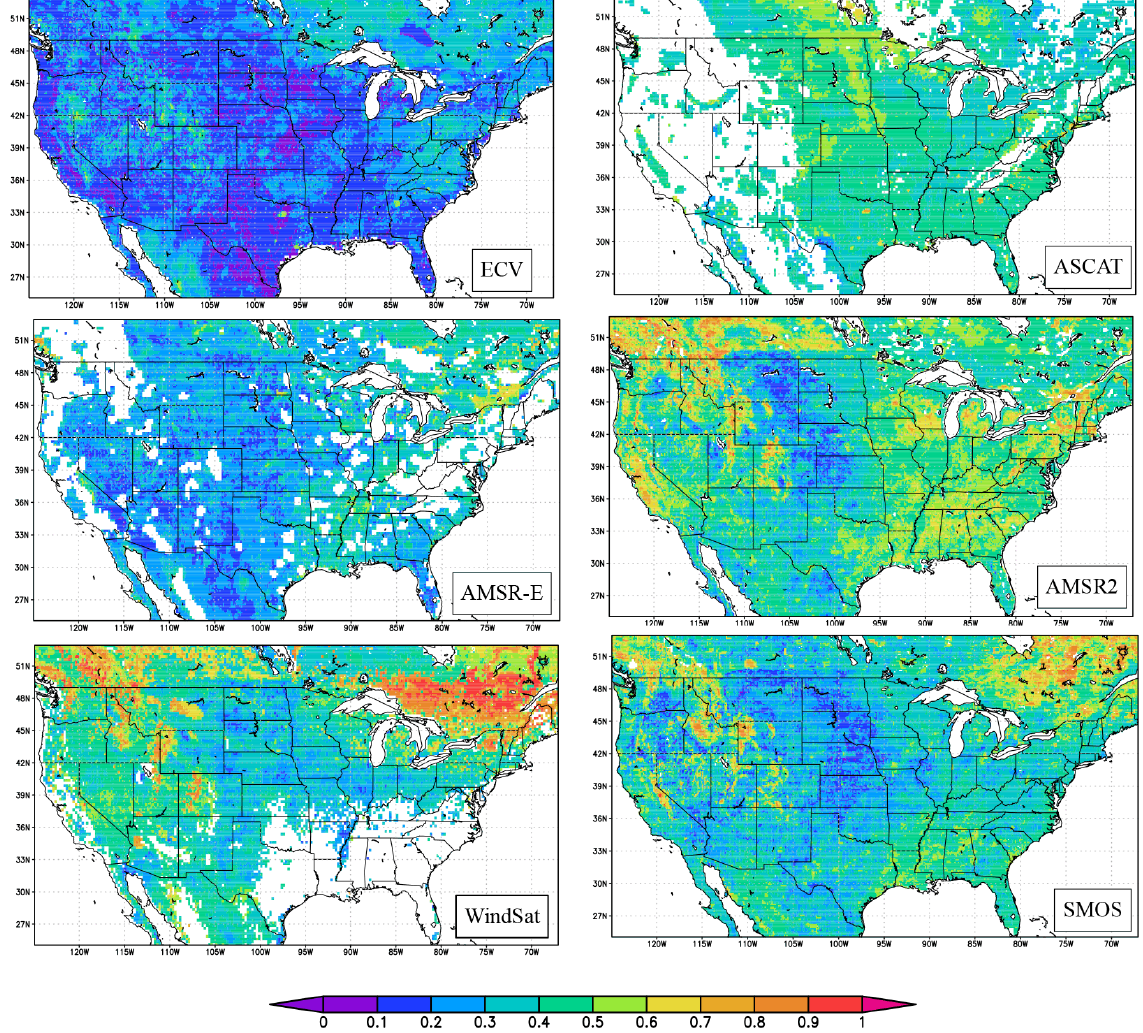
Figure 5. K–S distance ( D ) from the comparison of soil moisture distributions from the land surface model and various satellite remote sensing data sets. Grid points in white color indicate locations that are omitted from the K–S comparisons due to insufficient reliable